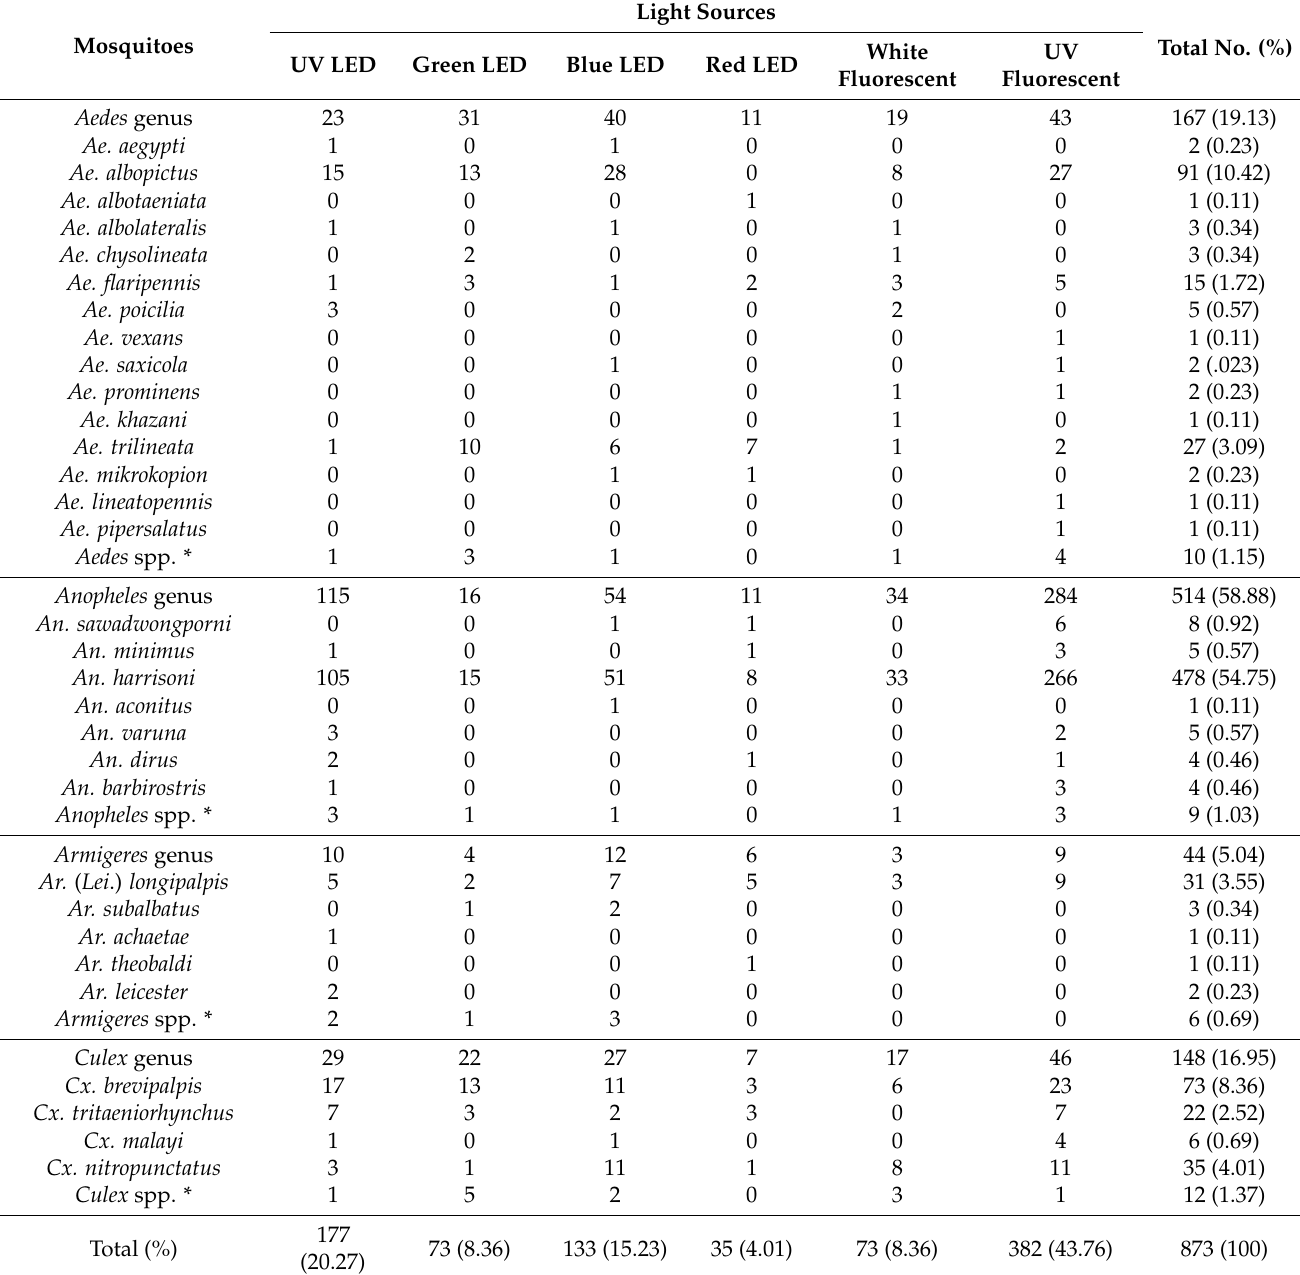
Table 2. Number and percentage of each adult mosquito species collected by using traps equipped with different light